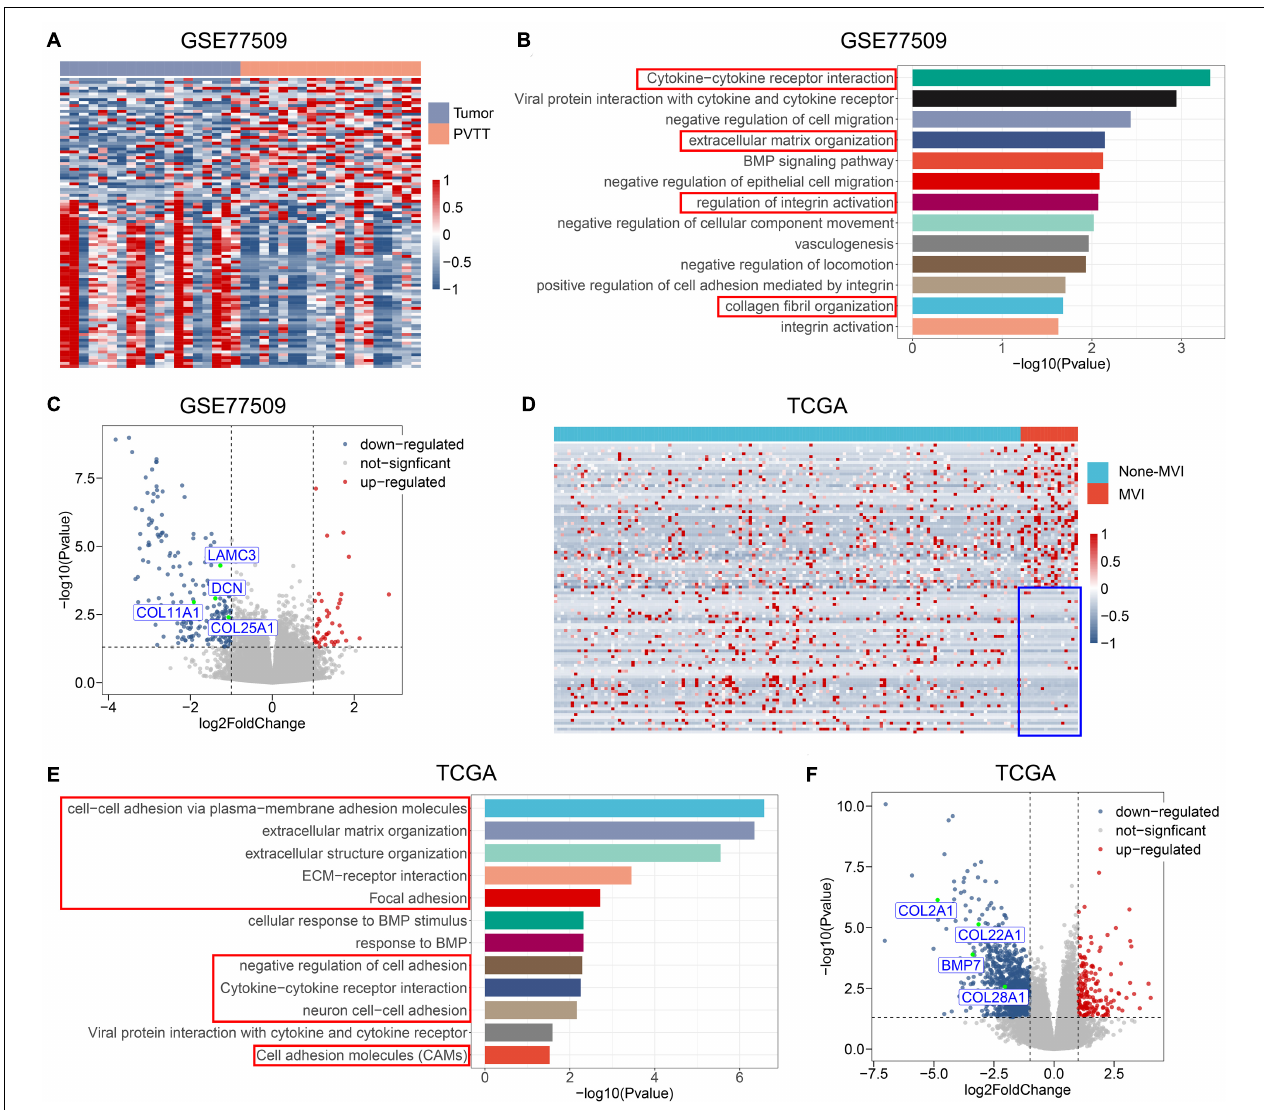
FIGURE 1 | ECM-related pathways and genes are involved in vascular invasion of HCC. (A) Heatmap of top 20 DEGs between tumor tissues and PVTT tissues from public dataset GSE77509; the colors represent Z-Score of log-normalized data. (B) The significantly altered molecular pathways between tumor tissues and PVTT tissues from public dataset GSE77509. Red frame indicates ECM-related pathways. (C) Volcano plot of DEGs in tumor tissues and PVTT tissues from public dataset GSE77509; multiple ECM-associated genes are shown. (D) Heatmap of top 20 DEGs between none-MVI tumor tissues and MVI tumor tissues from TCGA; the colors represent Z-Score of log-normalized data. Blue frame indicates consistent lower expression of top 20 downregulated genes in MVI group across patients. (E) The significantly altered molecular pathways between none-MVI tumor tissues and MVI tumor tissues from TCGA. Red frame indicates ECM-related pathways. (F) Volcano plot of DEGs in none-MVI tumor tissues and MVI tumor tissues from TCGA, and multiple ECM-associated genes are represented. MVI, microvascular invasion; TCGA, The Cancer Genome